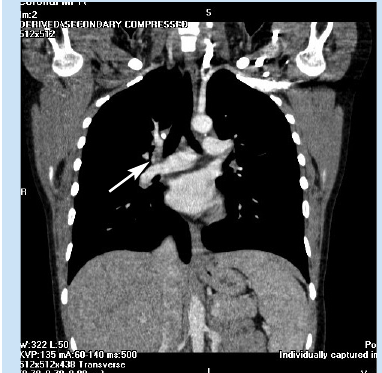
Fig. 3. Coronal image showing the normal vertical course of the partially opacified